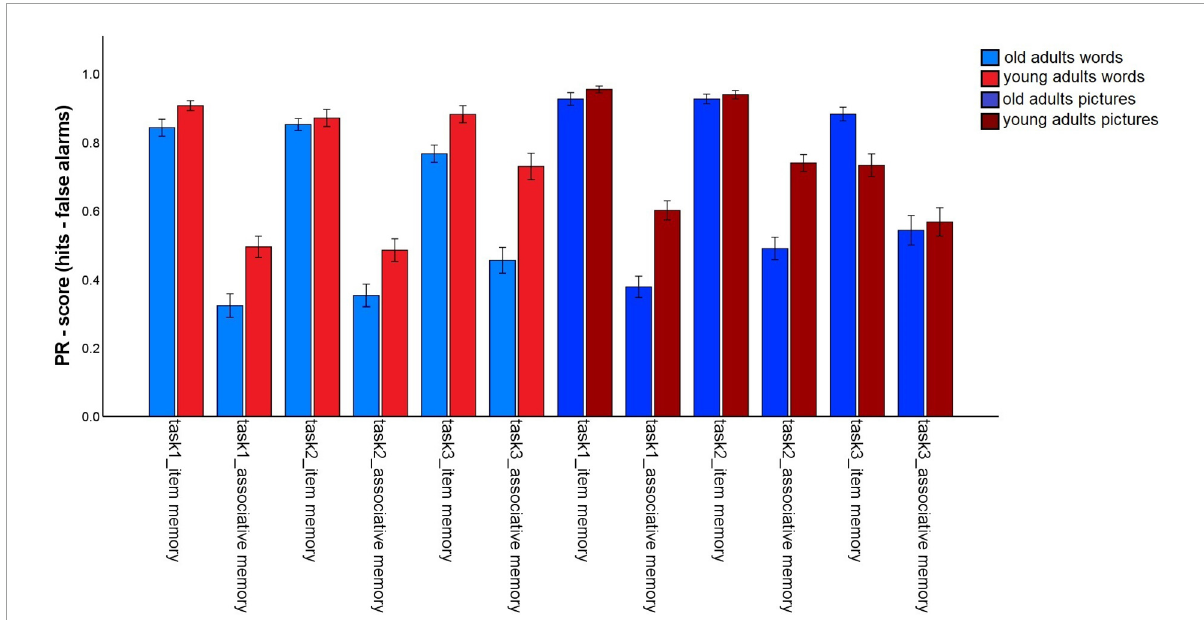
FIGURE2 Pr-Scores of item memory and associative memory for words and pictures, separated for younger and older subjects and for the three different tasks in the first session. Task 1: Incidental pleasantness judgment task, task 2: intentional pleasantness judgment task, task 3: free strategy selection. Error bars represents the standard error of the